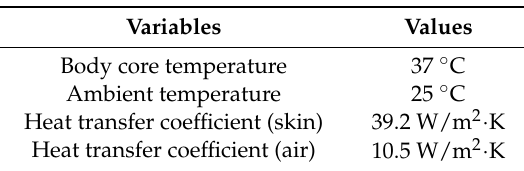
Table 2. Variables related to human body application. Heat transfer coefficients are the calculated values from experimental data of the human body